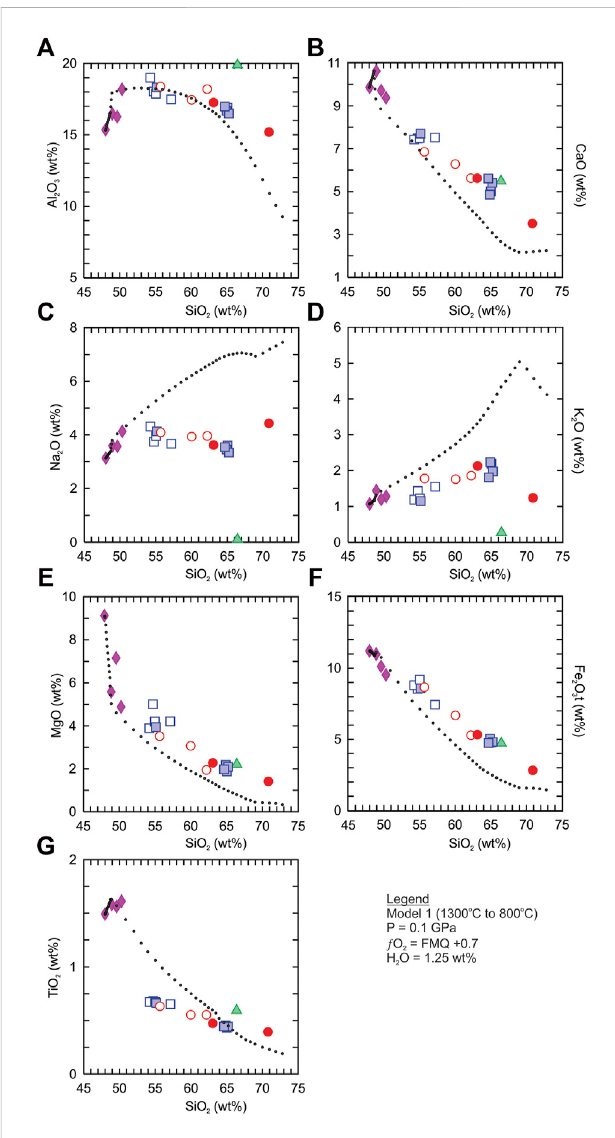
(wt%), and (G) TiO 2 (wt%) vs. SiO 2 (wt%). The residual silicic liquids compositions are at 10 ° C intervals. The complete modeling results are in online Supplementary Table S6. All data are normalized to 100%. Symbols of the Snoul pluton are the same as in Figure